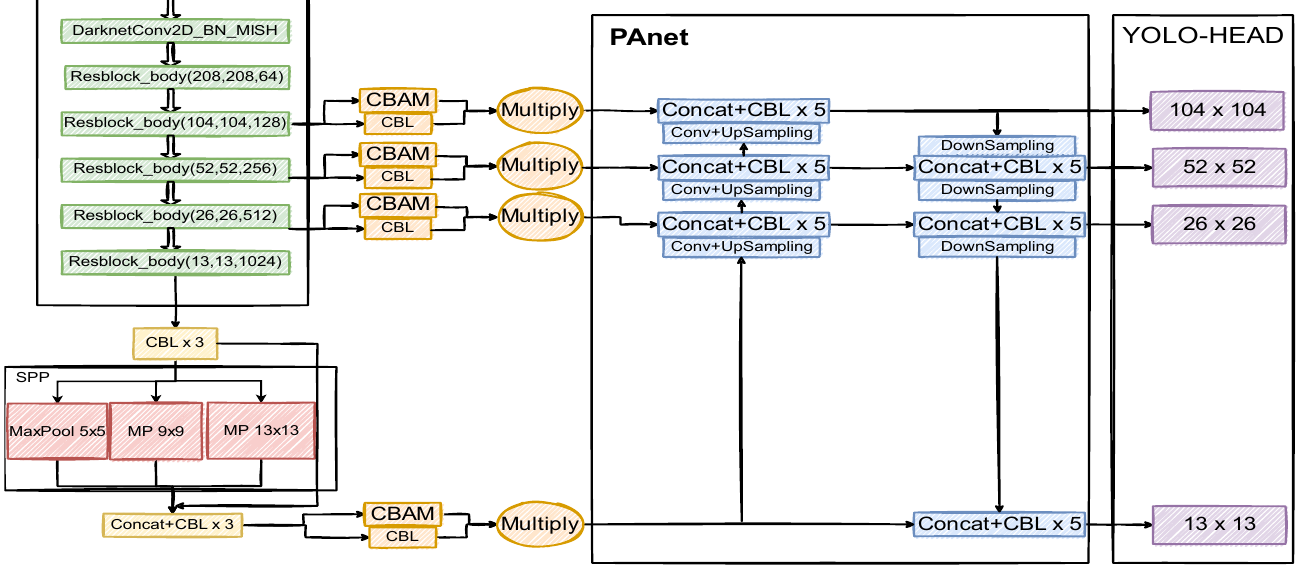
Figure 5. Improved YOLOv4 network